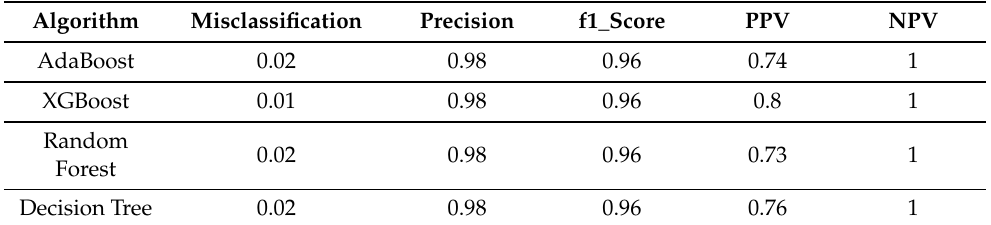
Table 4. Classification report after applying different machine learning approaches on the VDengue